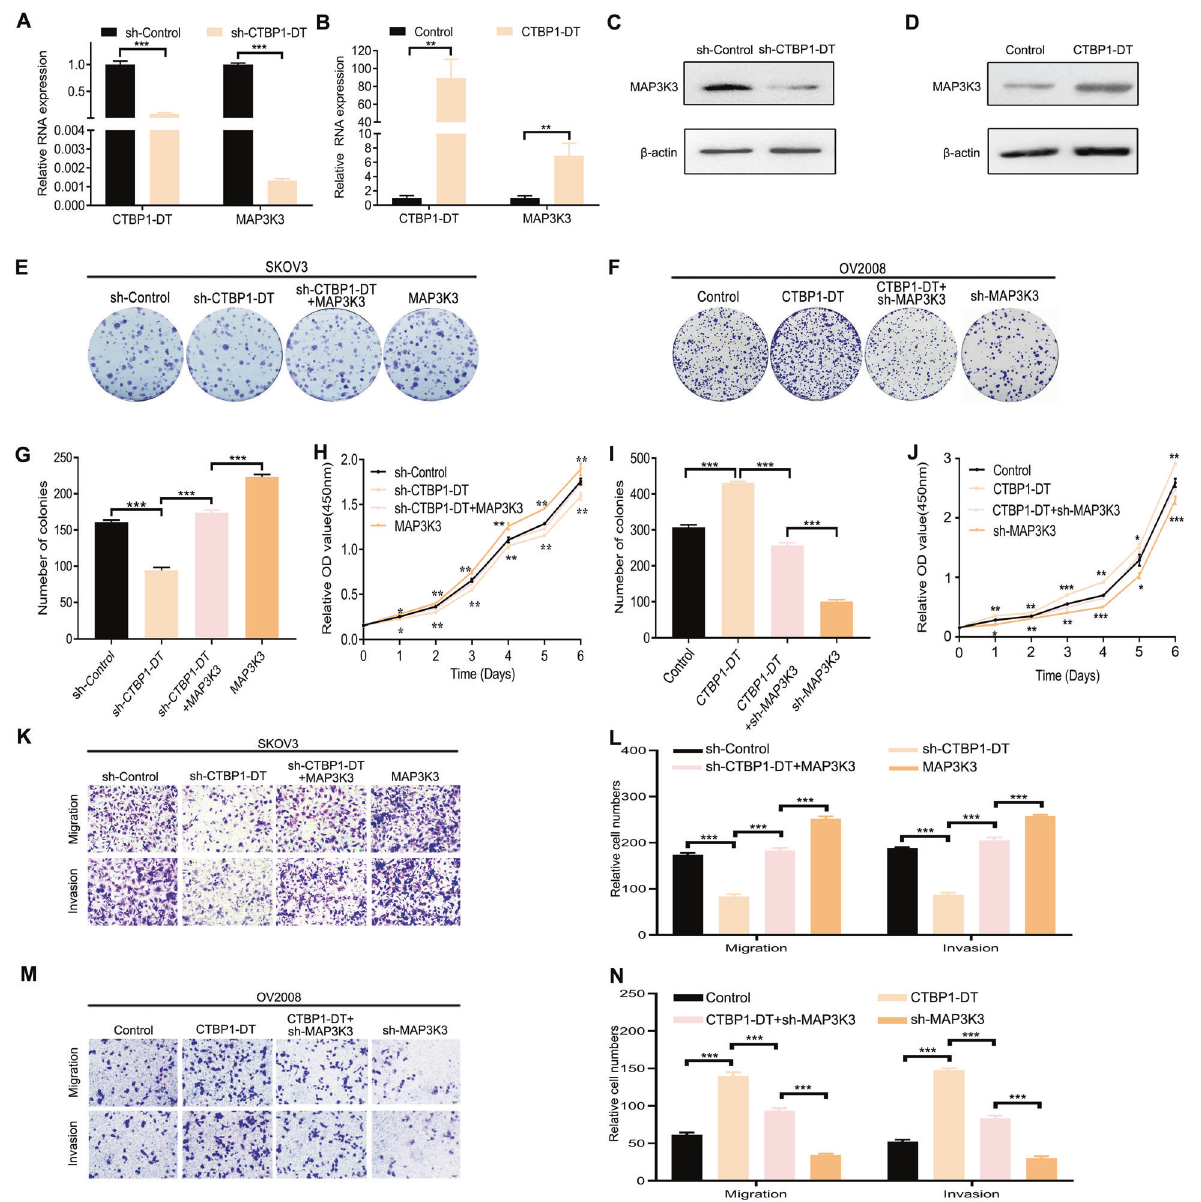
Fig. 3 LncRNA CTBP1-DT promotes the malignant biological behaviour of HGSOC cells by upregulating MAP3K3. A , B LncRNA CTBP1-DT knockdown resulted in decreased expression of MAP3K3 in SKOV3 cells, lncRNA CTBP1-DT overexpression resulted in increased expression of MAP3K3 in OV2008 cells. C , D The ef fi ciency of lncRNA CTBP1-DT knockdown or overexpression was detected by western blot assay in SKOV3 and OV2008. E , G , H CCK-8 assays and colony formation assays were performed to determine the proliferation ability of SKOV3 cells transfected with NC, sh-lncRNA CTBP1-DT, MAP3K3 and sh-lncRNA CTBP1-DT with MAP3K3, respectively. F , I , J The proliferation ability was detected by CCK-8 assays and colony formation assays of OV2008 cells transfected with NC, lncRNA CTBP1-DT, sh-MAP3K3 and lncRNA CTBP1- DT with sh-MAP3K3. K , L Migration and invasion assays of SKOV3 cells with lncRNA CTBP1-DT knockdown and MAP3K3 overexpression. M , N Migration and invasion assays of OV2008 cells with lncRNA CTBP1-DT overexpression and MAP3K3 knockdown. Data are presented as the mean ± SEM. * P < 0.05, ** P < 0.01, *** P <